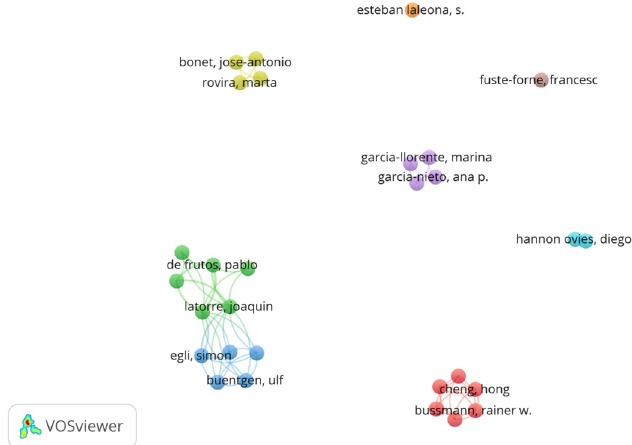
Figure 3. Authors. Own elaboration.